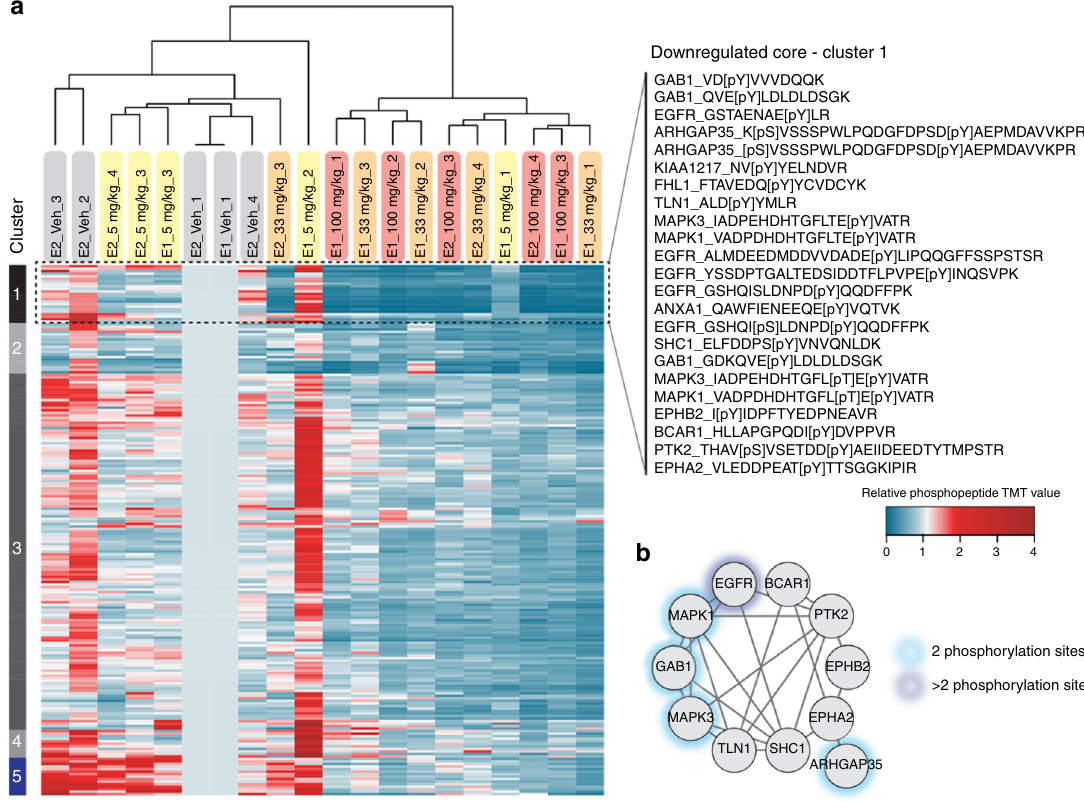
Fig. 5 In vivo phosphorylation changes in erlotinib-treated fl ank tumors reveal inhibition of EGFR signaling. a Hierarchical clustering (Euclidian distance) of phosphopeptide changes for GBM12 fl ank tumors treated with 5, 33, and 100 mg kg − 1 erlotinib ( n = 4) and displayed relative to a vehicle-treated fl ank tumor measured in both of the analyzed TMT-10-plex MS runs (E1 and E2), b Phosphoprotein interaction network based on STRING for members of cluster 1 in a and represented by their gene